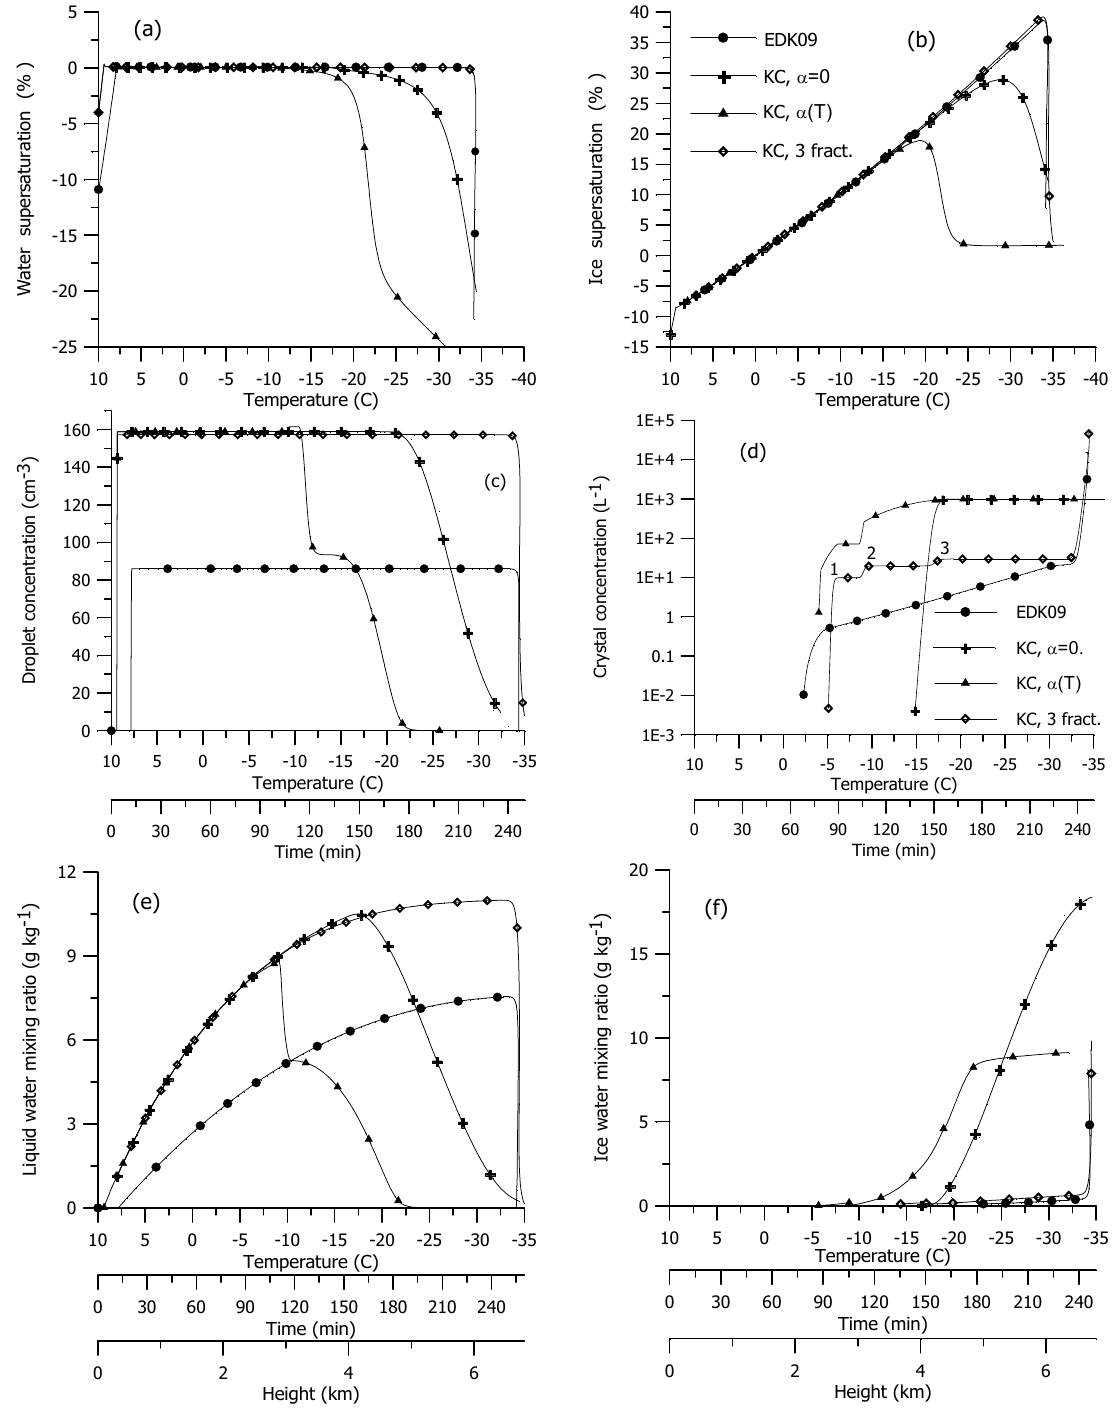
Fig. 2. Comparison of the temperature and time dependencies of cloud microphysical properties in the parcel runs obtained in simulations EDK09 with parameterization PDA08 (solid circles) and obtained in simulations of this work using KC scheme with DHetF mode in 3 simulations (see Table 1): (#1) only 2nd aerosol mode included as in EDK09, N d2 = 1cm − 3 (1000l − 1 ) , σ d2 = 2, r d2 = 0 . 4µm, and active site area α = 0 (crosses); (#2) only the same 2nd aerosol mode and variable α ( T ) as described by Eq. (12) (triangles); (#3) 3 IN fractions included with 3 values of contact parameter, 0.85, 0.75 and 0.5, and concentrations 10, 10 and 10l − 1 (diamonds). The 3 nucleation impulses in N c in the run #3 are denoted by the numbers (Fig. 2d). The parameters: w = 50cms − 1 , RHW 0 = 96%, T 0 = 10 ◦